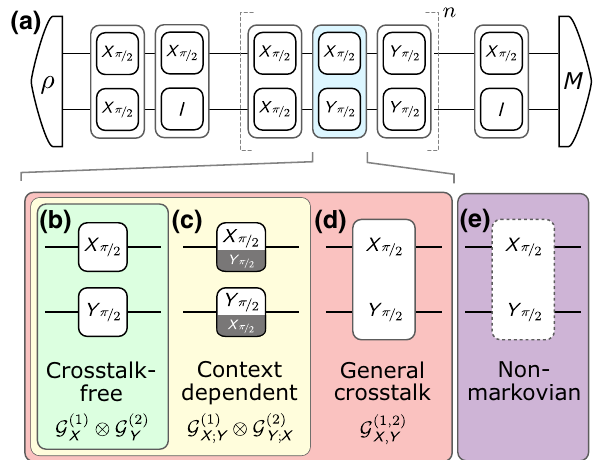
FIG. 1. Detecting and measuring crosstalk errors with gate set tomography. To probe crosstalk between two qubits, we execute a set of two-qubit quantum circuits (a) whose layers comprise parallel, single-qubit gates. These circuits consist of initializa- tion into ρ ≈ | 00 (cid:4)(cid:5) 00 | , a short state-preparation operation, an n -fold repeated germ operation, a short measurement-preparation operation, and finally measurement in the computational basis.